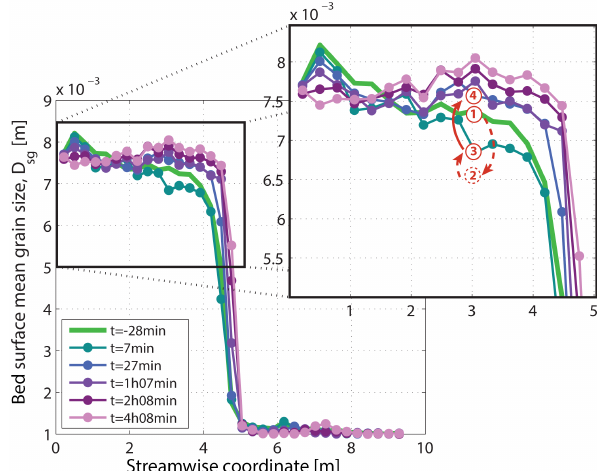
Figure 9. Measured geometric mean grain size of the bed surface sediment at various times for Experiment T 2 . Points 1 to 4 in the en- larged window show the temporal change in the bed surface. Point 2 indicates a hypothetical (i.e., not measured; see Fig. 8b) finer surface at the moment of the breakup. Point 3 corresponds to the coarser bed surface shown in Fig. 8c right after the reformation of the armor.